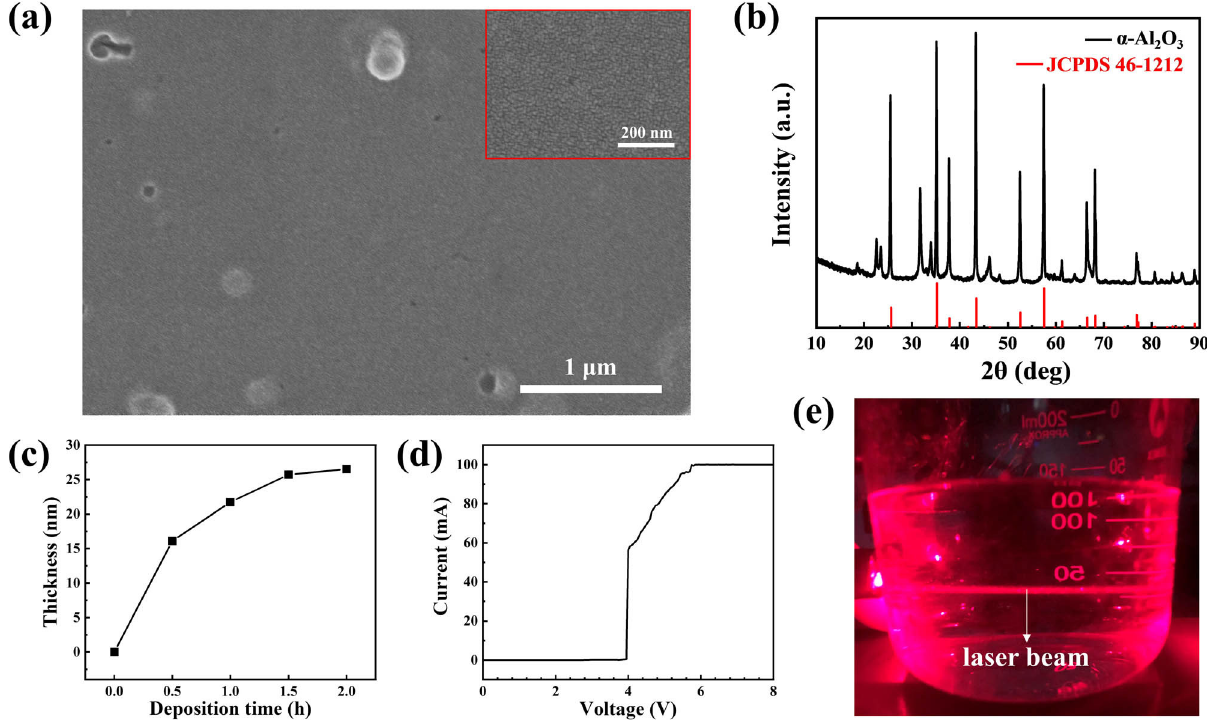
Figure 3: Material characterizations of the CLD - Al 2 O 3 . ( a ) SEM image of the CLD - Al 2 O 3 thin fi lm on ITO glass. The inset is an SEM image with much higher magni fi cation where no features other than a continuous and fl at fi lm have been detected. ( b ) XRD curve of the CLD - Al 2 O 3 ( 1,000°C annealing ) . ( c ) Deposition thickness of the CLD - Al fi lm as a function of the growth time. ( d ) I – V characteristics of the 23 nm 2 O 3 CLD - Al 2 O 3 thin fi lm sandwiched between two electrodes. The electrical breakdown occurs at ∼ 4 V. ( e ) The Tyndall e ff ect observed in the 1:1 diluted liquid. The horizontal laser beam is clearly